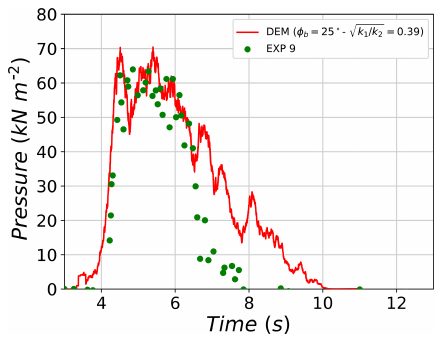
Figure 17. Maximum pressure applied to the large sensor for exper- imental data and their corresponding best-fit DEM simulations.